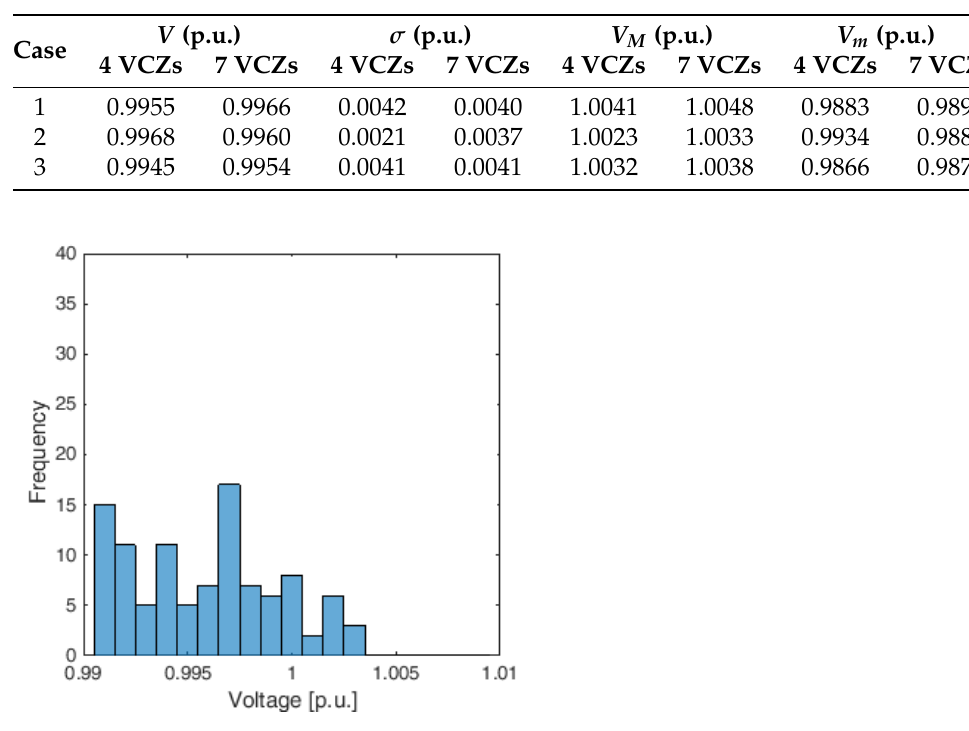
Figure 9. The histogram of the distribution of the nodal voltages for the Decentralized APP in Case 3 with the partitioning in four VCZs .